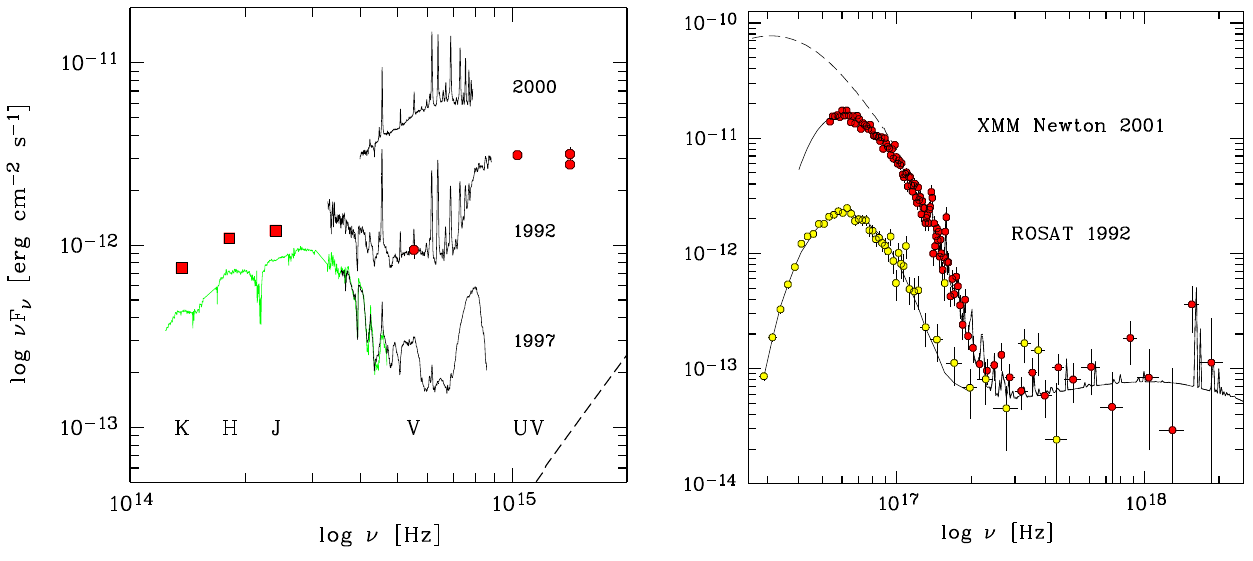
Figure 2: Spectral energy distribution of the polar RX J1007.5-2017 at different epochs (from: Thomas et al. 2012) The right panel shows the incident spectra for the 2001 XMM pn observation (red filled circles) and the 1992 ROSAT PSPC observation (open circles). The dashed curve illustrates the “source spectrum” cor- rected for interstellar absorption (Thomas et al.,